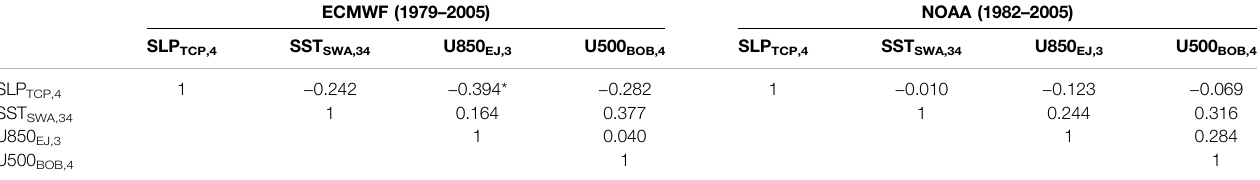
Values with single asterisk represent they are signi fi cant at the 95% con fi dence levels.